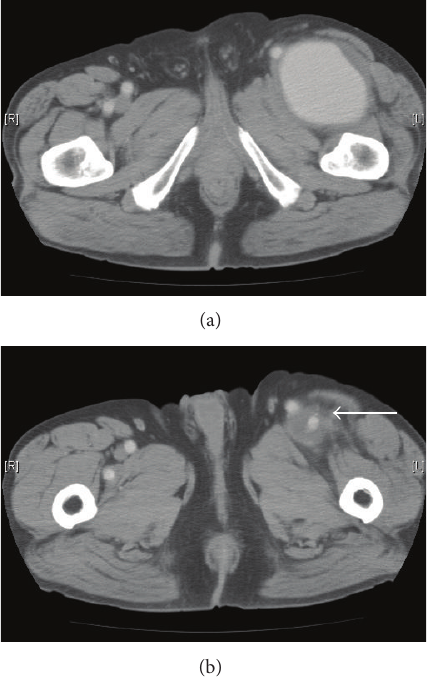
Figure 4: Computed tomography showed a 78 × 86 mm left pro- funda femoris artery (PFA) (a), which extended to the distal part of the left PFA (white arrow)